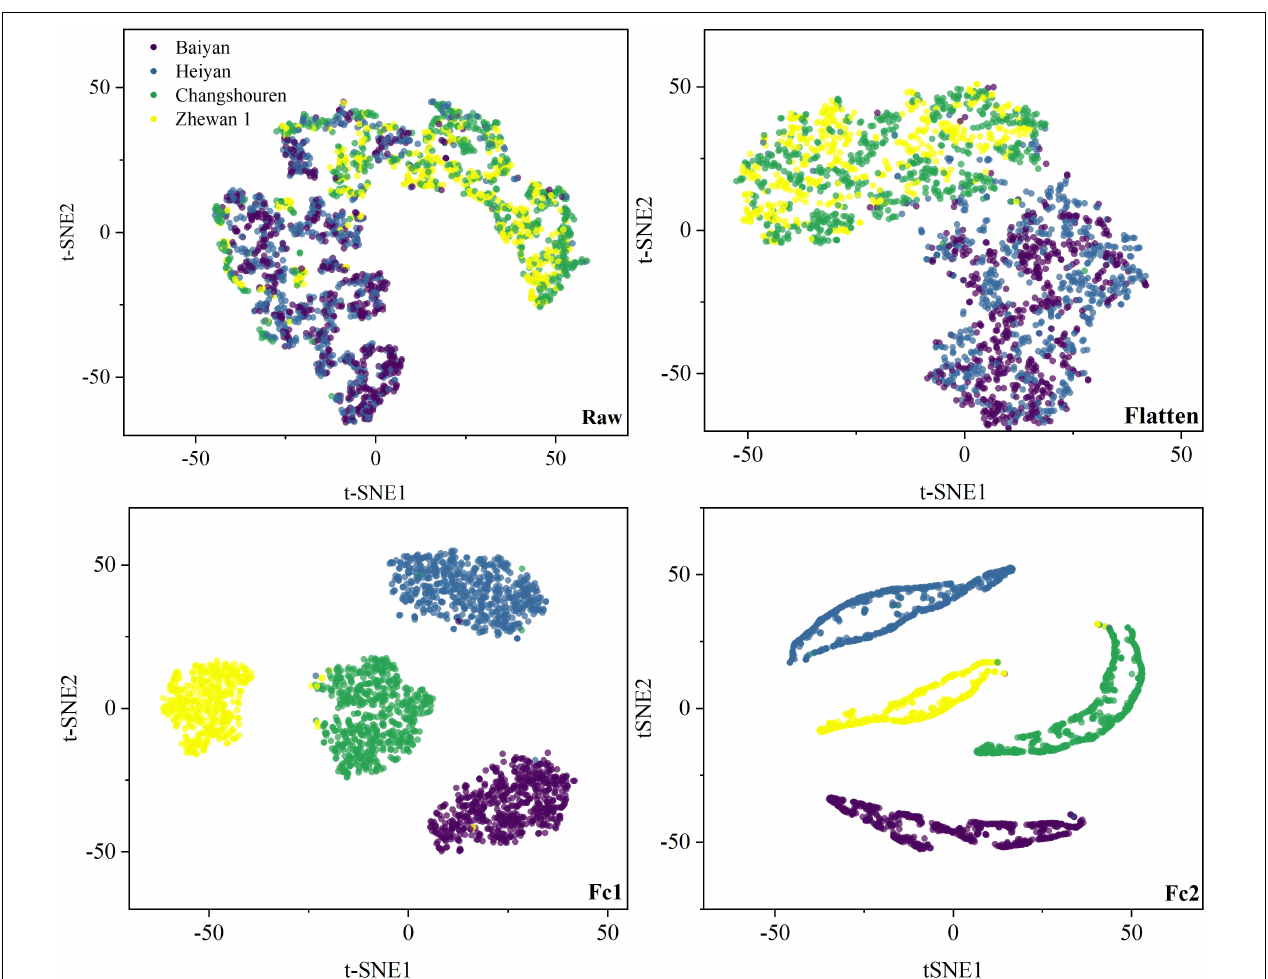
FIGURE 6 | Feature visualization of VGG-MODEL on the Pea dataset, using t-SNE.